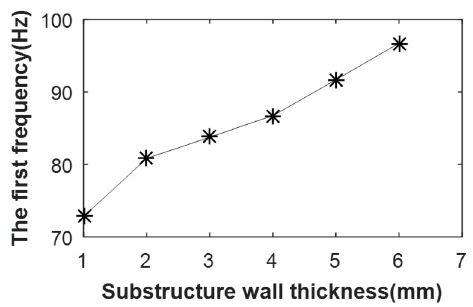
Figure 26. Thickness-frequency curve of substructure 6.